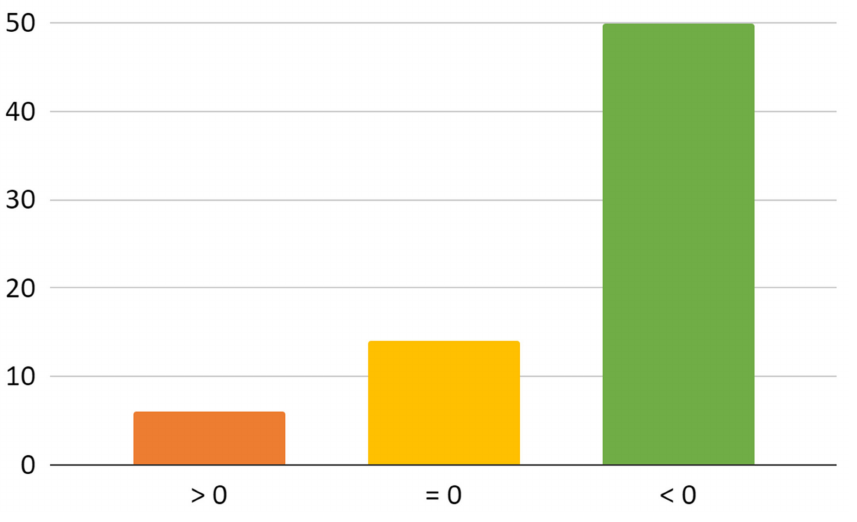
Figure A1. Number of joints with increasing pain (>0), unchanged pain (=0), and pain reduction (<0) based on differences in VAS scores during treatment.